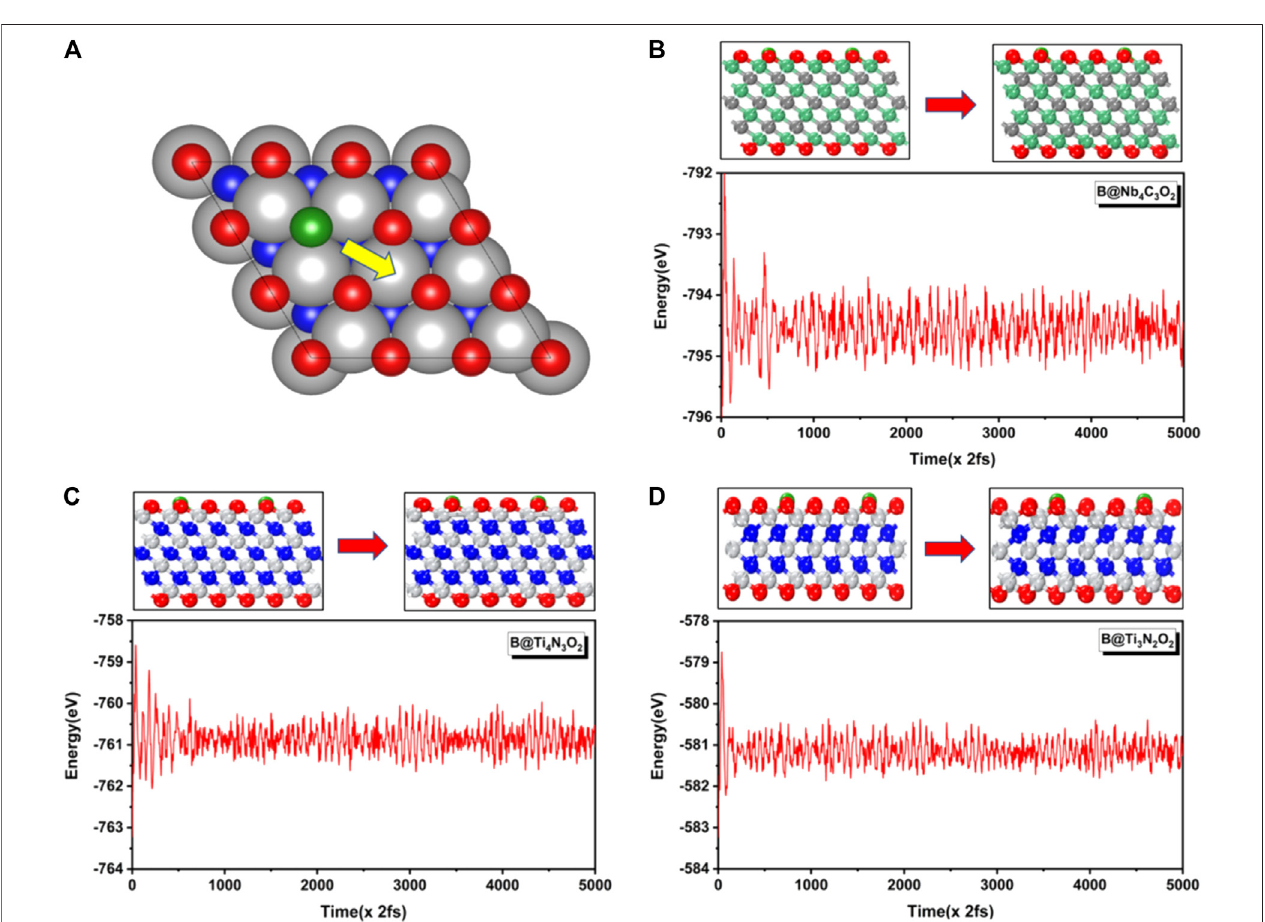
FIGURE7 | (A) The diffusion path ofB atom from O vacancy to the adjacent adsorption site on MXenes. Variations ofenergyagainst the time for AIMD simulations of (B)